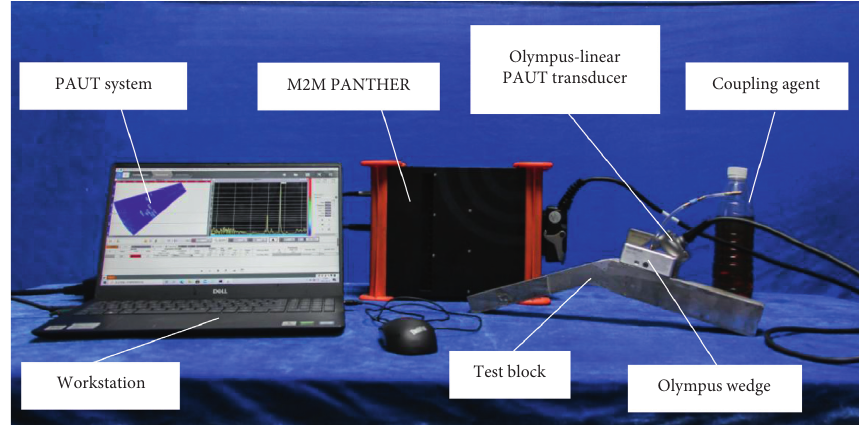
Figure 5: PAUT experimental system of irregular structure weld defective test block.